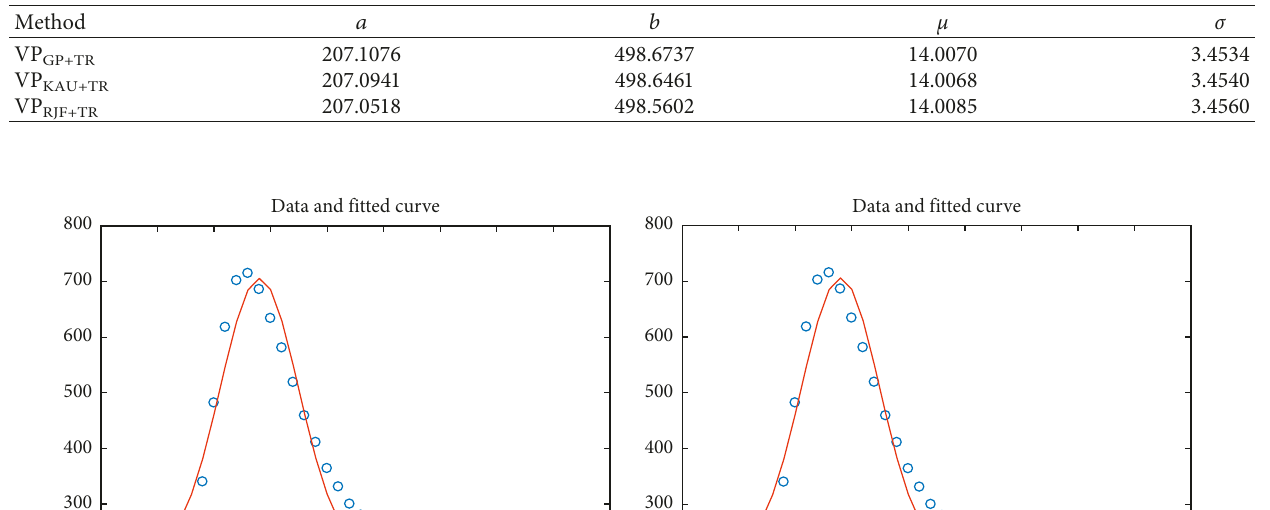
GP+TR . (b) VP KAU+TR . (c) VP RJF+TR